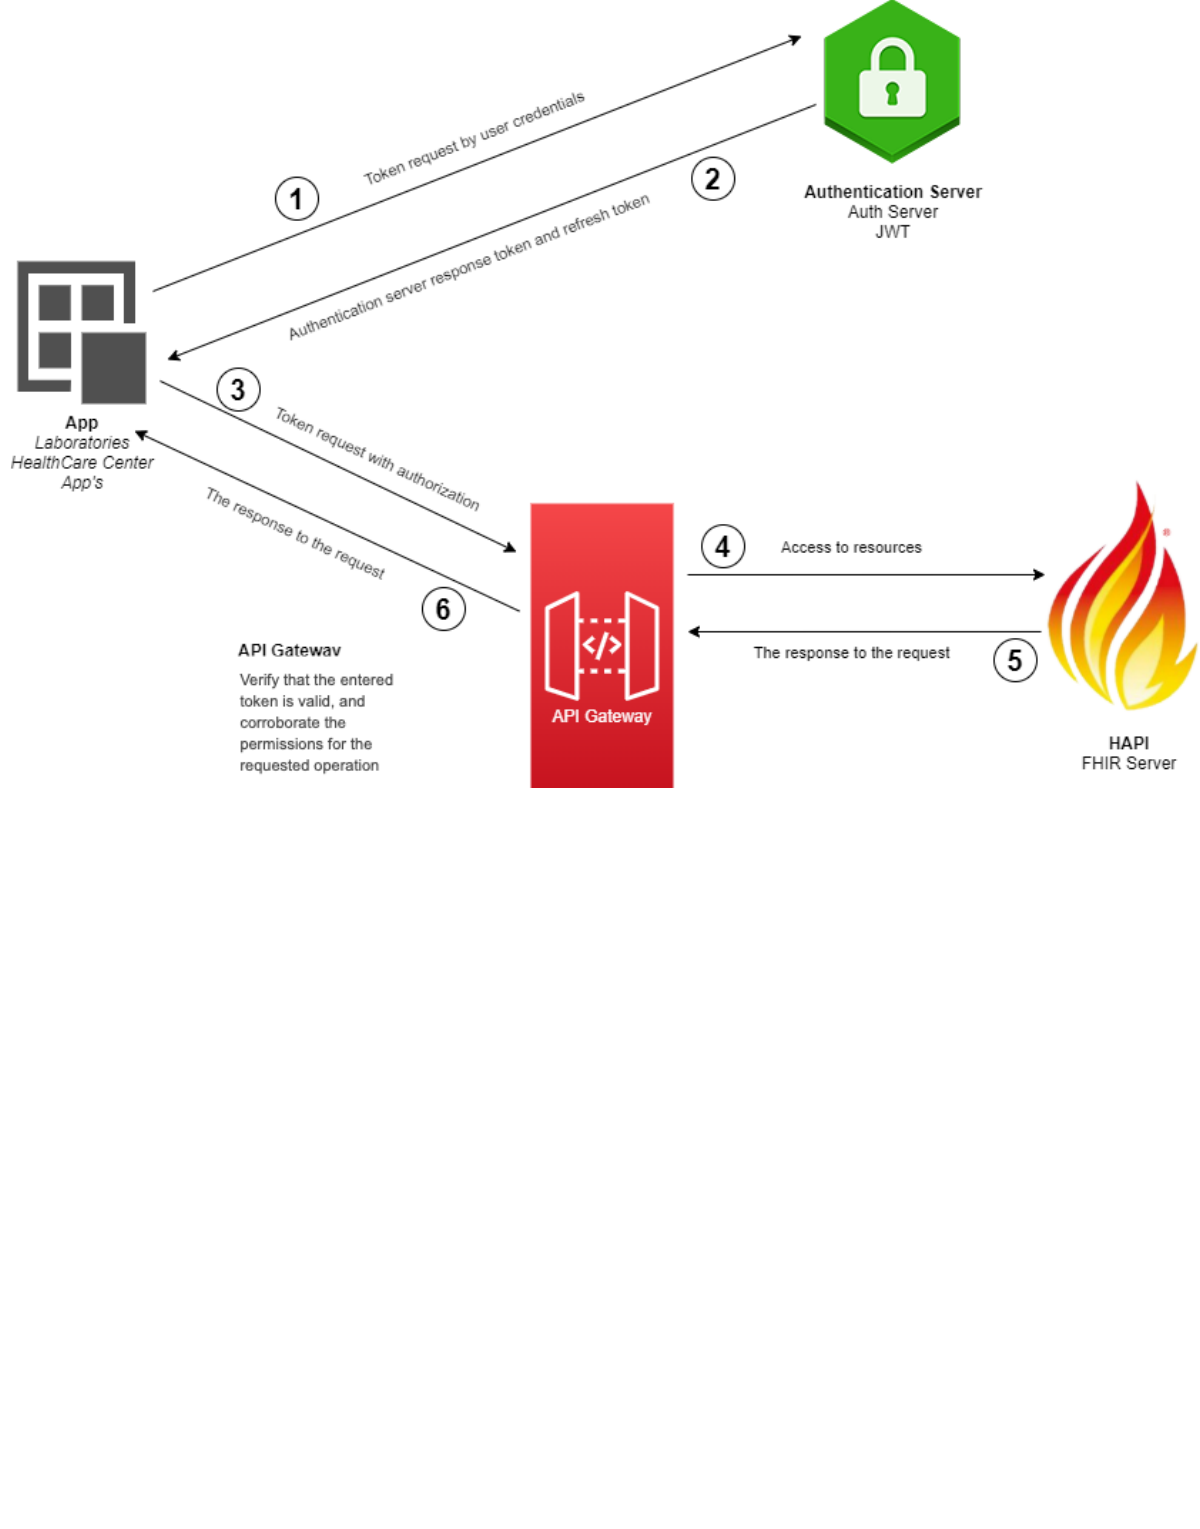
Figure 6. JWT authentication server. The security layer was configured with JWT to obtain valid credentials and access the HAPI FHIR server.